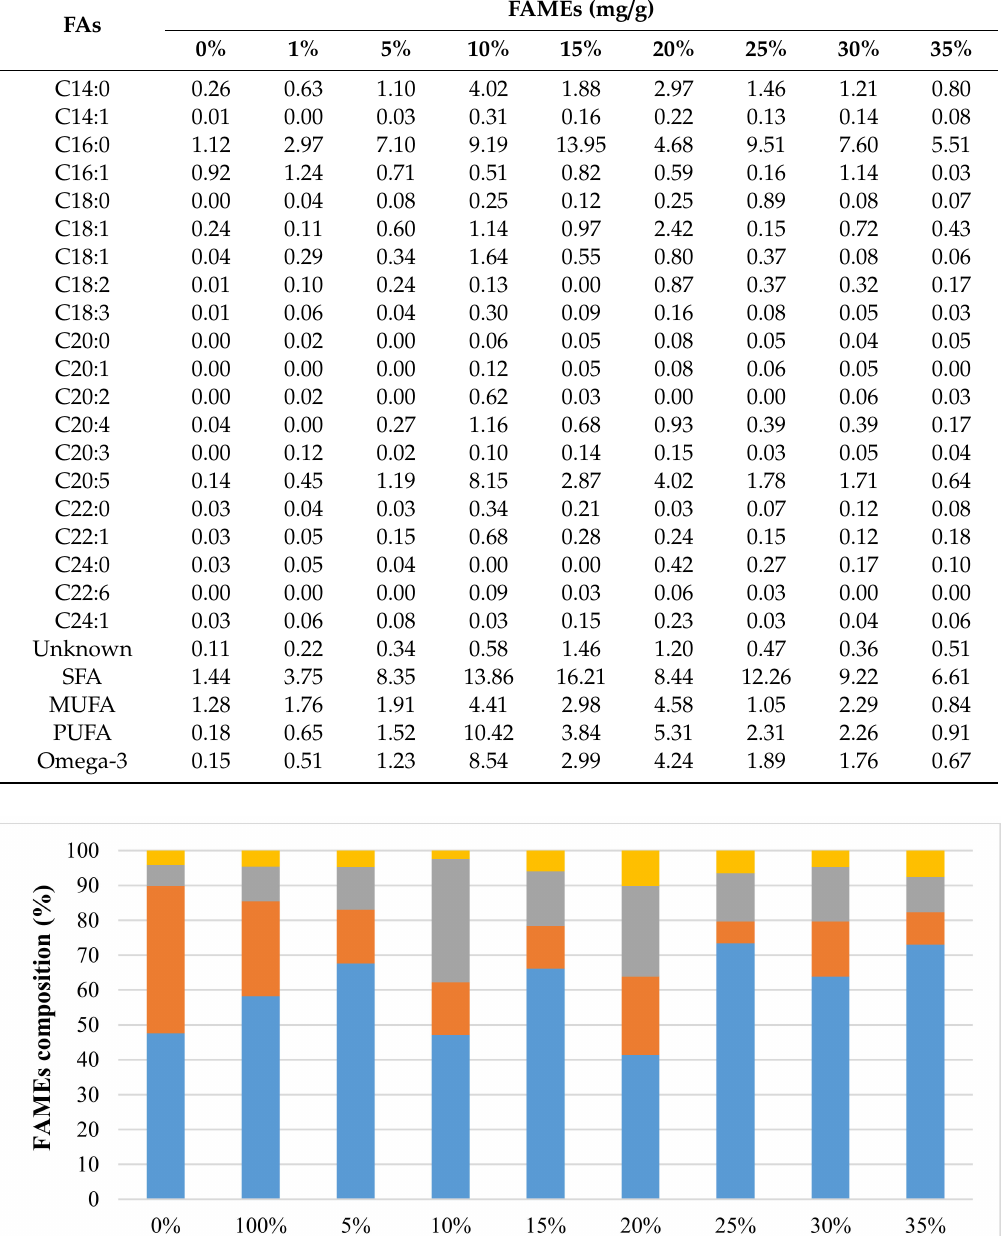
Table 3. The fatty acid methyl esters (FAMEs) composition of Nannochloropsis sp . microalgae (in mg / g) at di ff erent salt concentrations (0%–35%) using MAE at 10% ( w / v ) solid Loading, 100 ◦ C and 5 min.